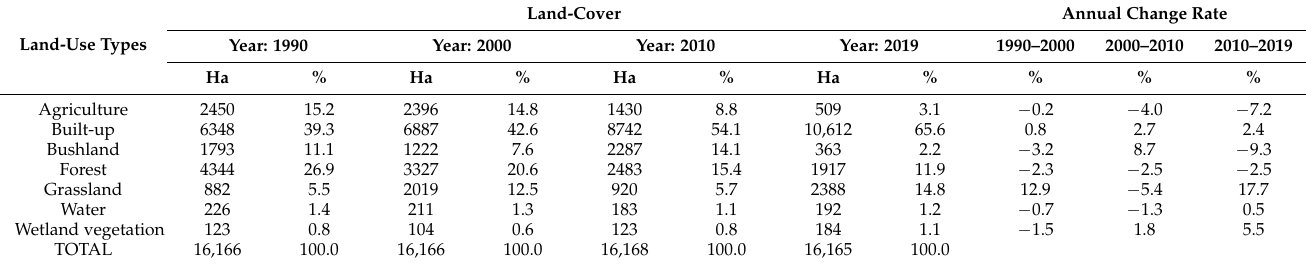
Figure 2. Land-use land-cover maps for ( a ) 1990, ( b ) 2000, ( c ) 2010 and ( d ) 2019. Table 6. Land-use land-cover status and change between 1990 and 2019.